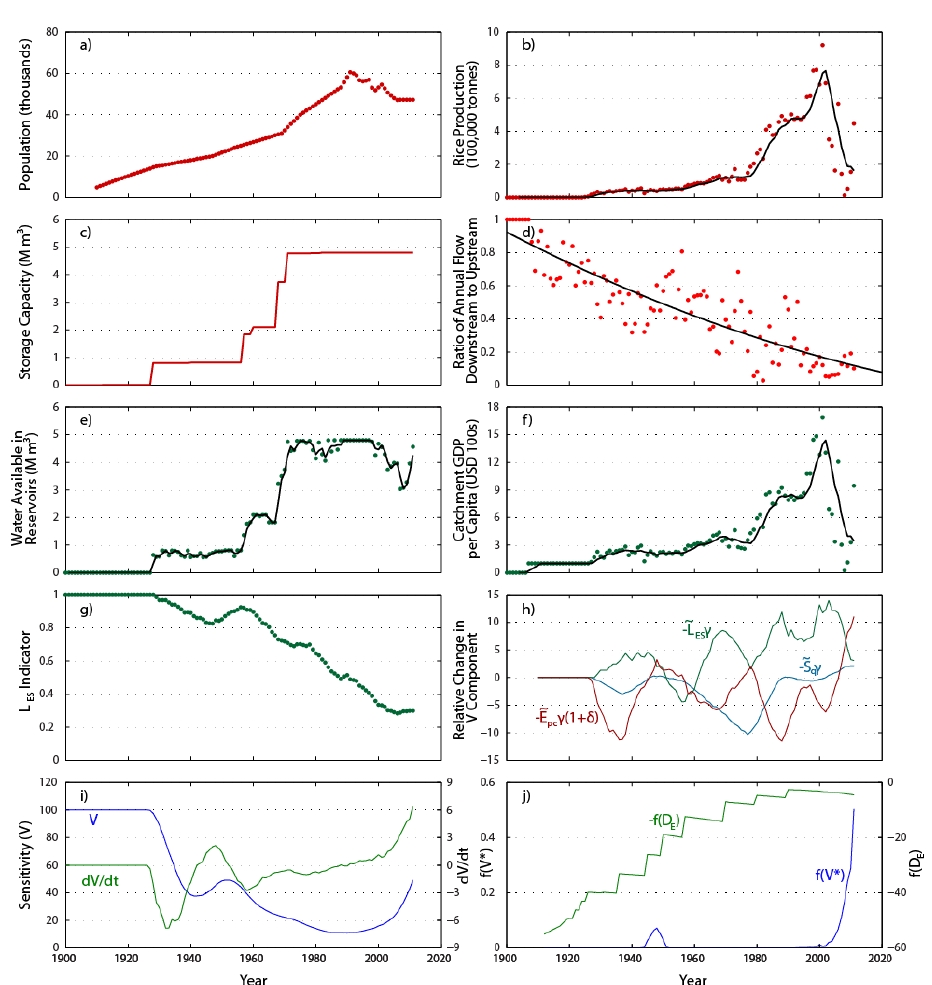
Figure 6. Stylised model data and results for a semi-idealised irrigated catchment, e.g. Murrumbidgee Catchment. (a) Catchment population growth ( P n ). (b) Rice production. (c) Development of dam and reservoir storage infrastructure ( S max ). (d) Environmental flow ( Q ES ), taken as the ratio of annual flow observed at Balranald to that observed at Wagga Wagga. (e) Water availability stored in dams and reservoirs ( S Q ) (data for (a–e) sourced from Fig. 4 in Kandasamy et al., 2014). (f) Catchment GDP per capita ( E pc ). (g) Lumped “lifestyle” ecosystem services indicator ( L ES ). (h) Evolution of the three underlying catchment-component drivers of Sensitivity ( V ) over time. (i) Evolution of Sensitivity ( V ) and d V/ d t over time. (j) Evolution of behavioural response component functions, f (V ∗ ) and f (D E ) , over